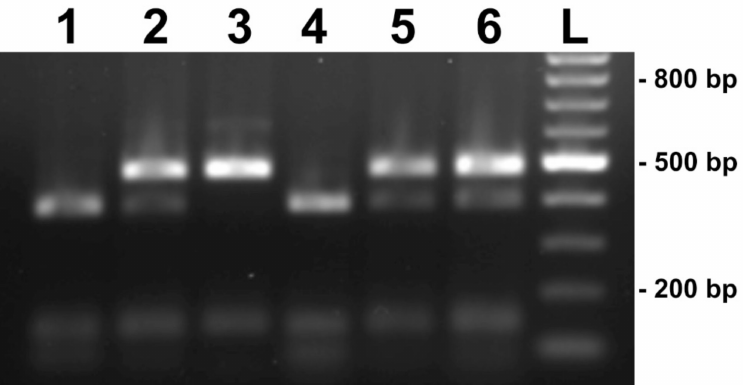
Figure 3. BstUI restriction fragment length polymorphisms of PCR amplified Bjerkandera adusta ITS regions. Lane1, B. adusta B1; Lane 2, B. adusta 859; Lane 3, B. adusta B2, Lane 4, B. adusta 692; Lane 5, B. adusta 884; Lane 6, B. adusta 994. L—standard of molecular weight. Gel electrophoresis in 1%